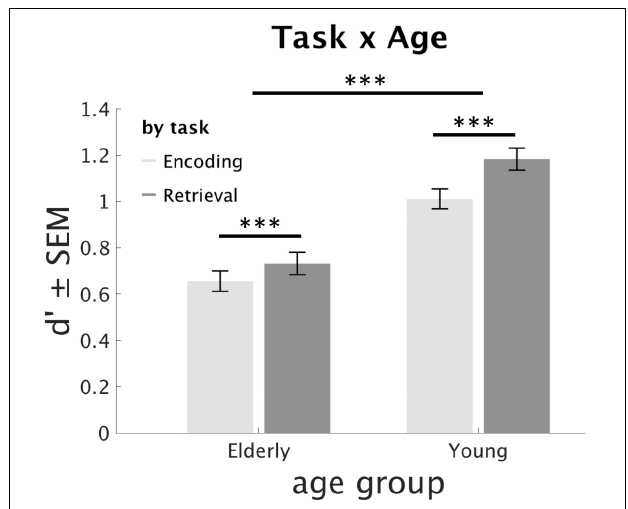
FIGURE 3 | Differential effect of retrieval practice (RP) on age group. Both young and older participants show the RPE, but it is significantly larger in the young. ∗∗∗ p <